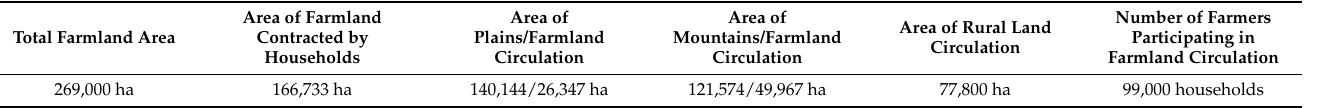
Table 4. Farmland circulation data of Zhangye